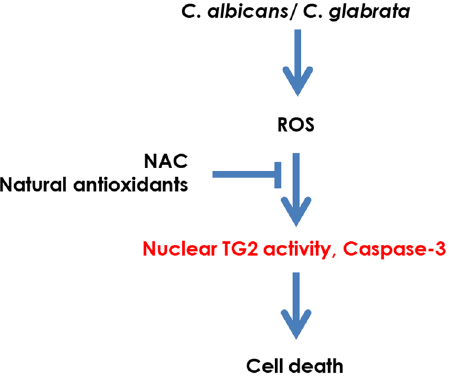
Figure 6. Schematic diagram showing the mechanism of C. albicans - and C. glabrata- induced cell death in HC cells. Both fungi produce ROS that induces cellular TG activity leading to HC cell death. NAC and natural antioxidants are effective in preventing this cell death by blocking the action of